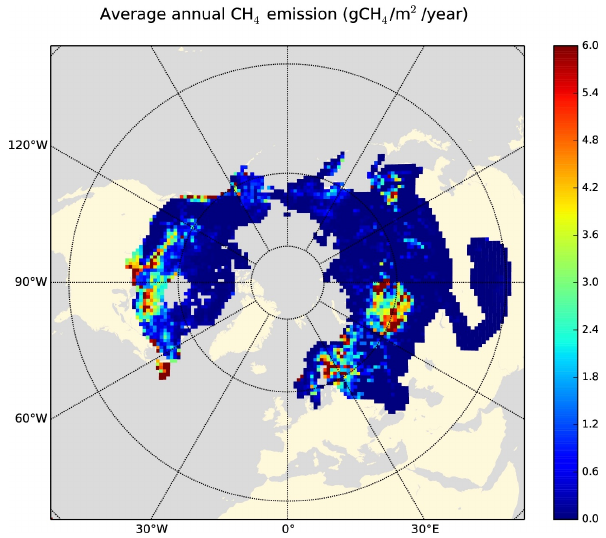
Figure 3. Average annual CH 4 emissions over the study domain for